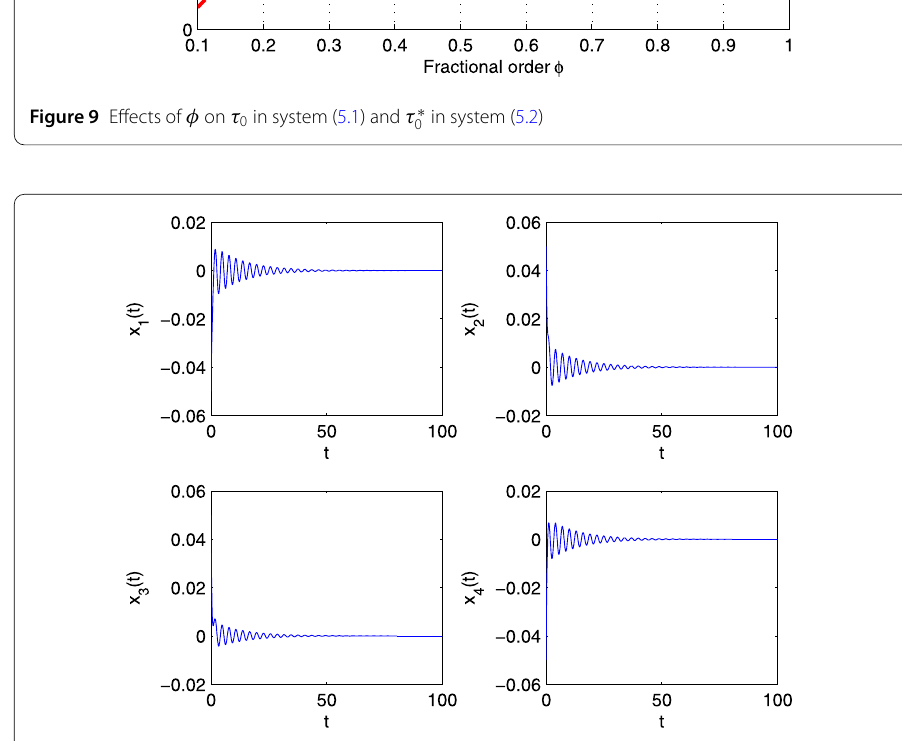
Figure 10 State response of system (5.3) with φ = 0.96, τ = 0.38 < τ 0 =